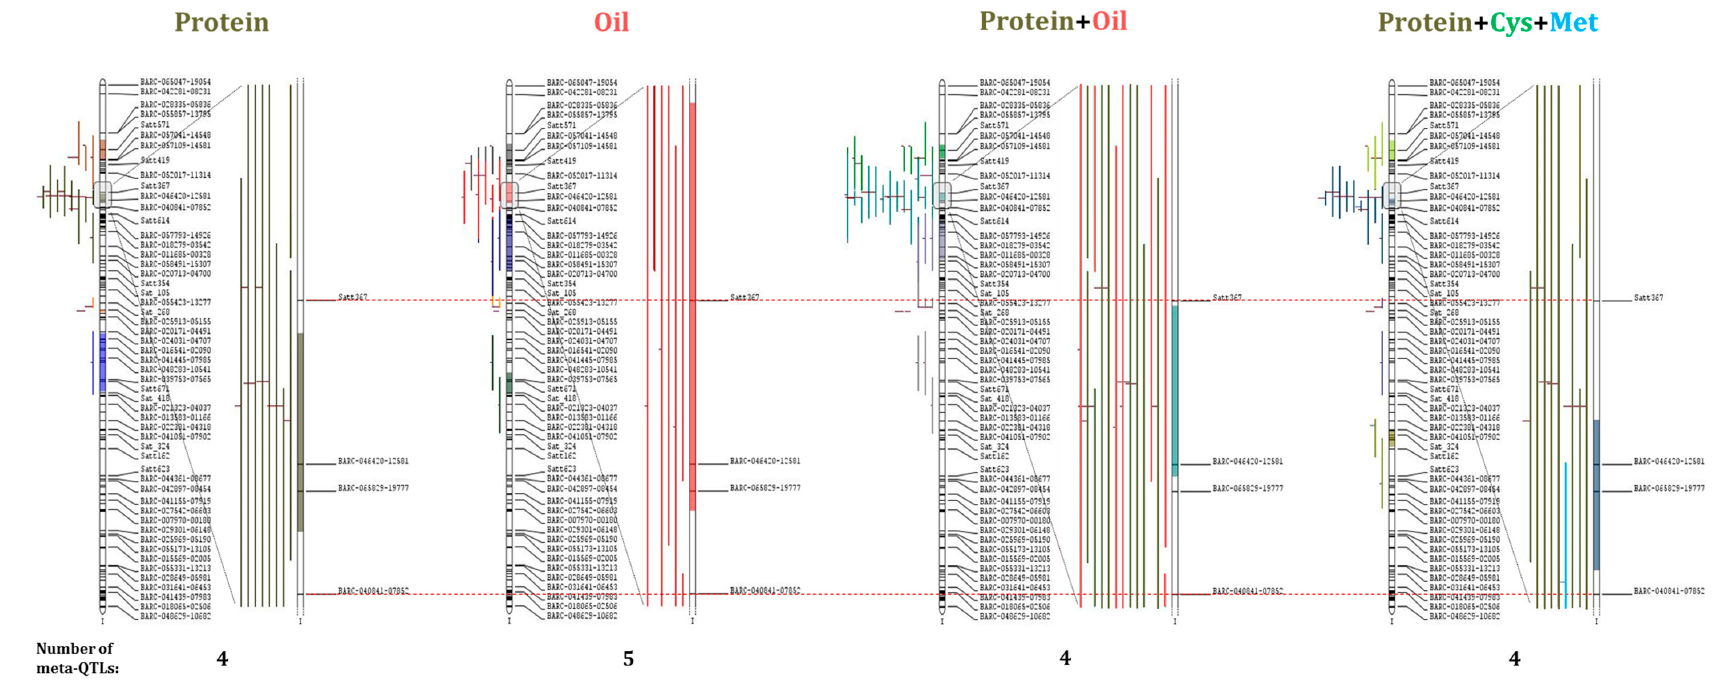
Figure 1. Comparisons among protein, oil, protein+oil and protein+Cys+Met meta-quantitative trait loci (meta-QTLs) on Chromosome (Chr) 20 (Linkage group I; LG I). Projected QTL are displayed to the left of Chr 20 for each trait or trait combination. A 95% of confidence interval of each meta-QTL is represented as filled colors on the chromosome arm, with four, five, four and four meta-QTLs identified for protein, oil, protein+oil and protein+Cys+Met, respectively. A detailed view of the projected QTL contributing to each meta-QTL cluster #2 of Chr 20 (Table 1) are also shown on the right of the chromosome. In the detailed view, each bar represents a projected QTL and is color-coded for each trait (protein, khaki; oil, red; cysteine, green; and methionine, blue).